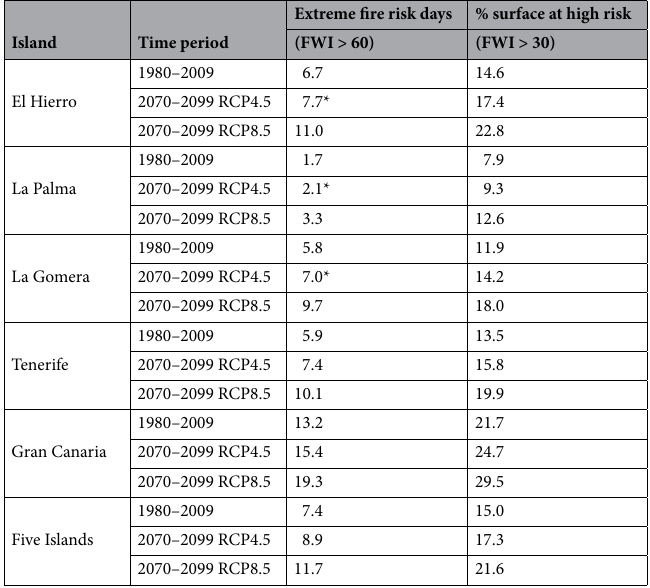
Table 1. Projected averaged changes, for each island, in extreme fire risk days and percentage of surface with a high risk of fire. *Statistically non-significant results, P > 0.05